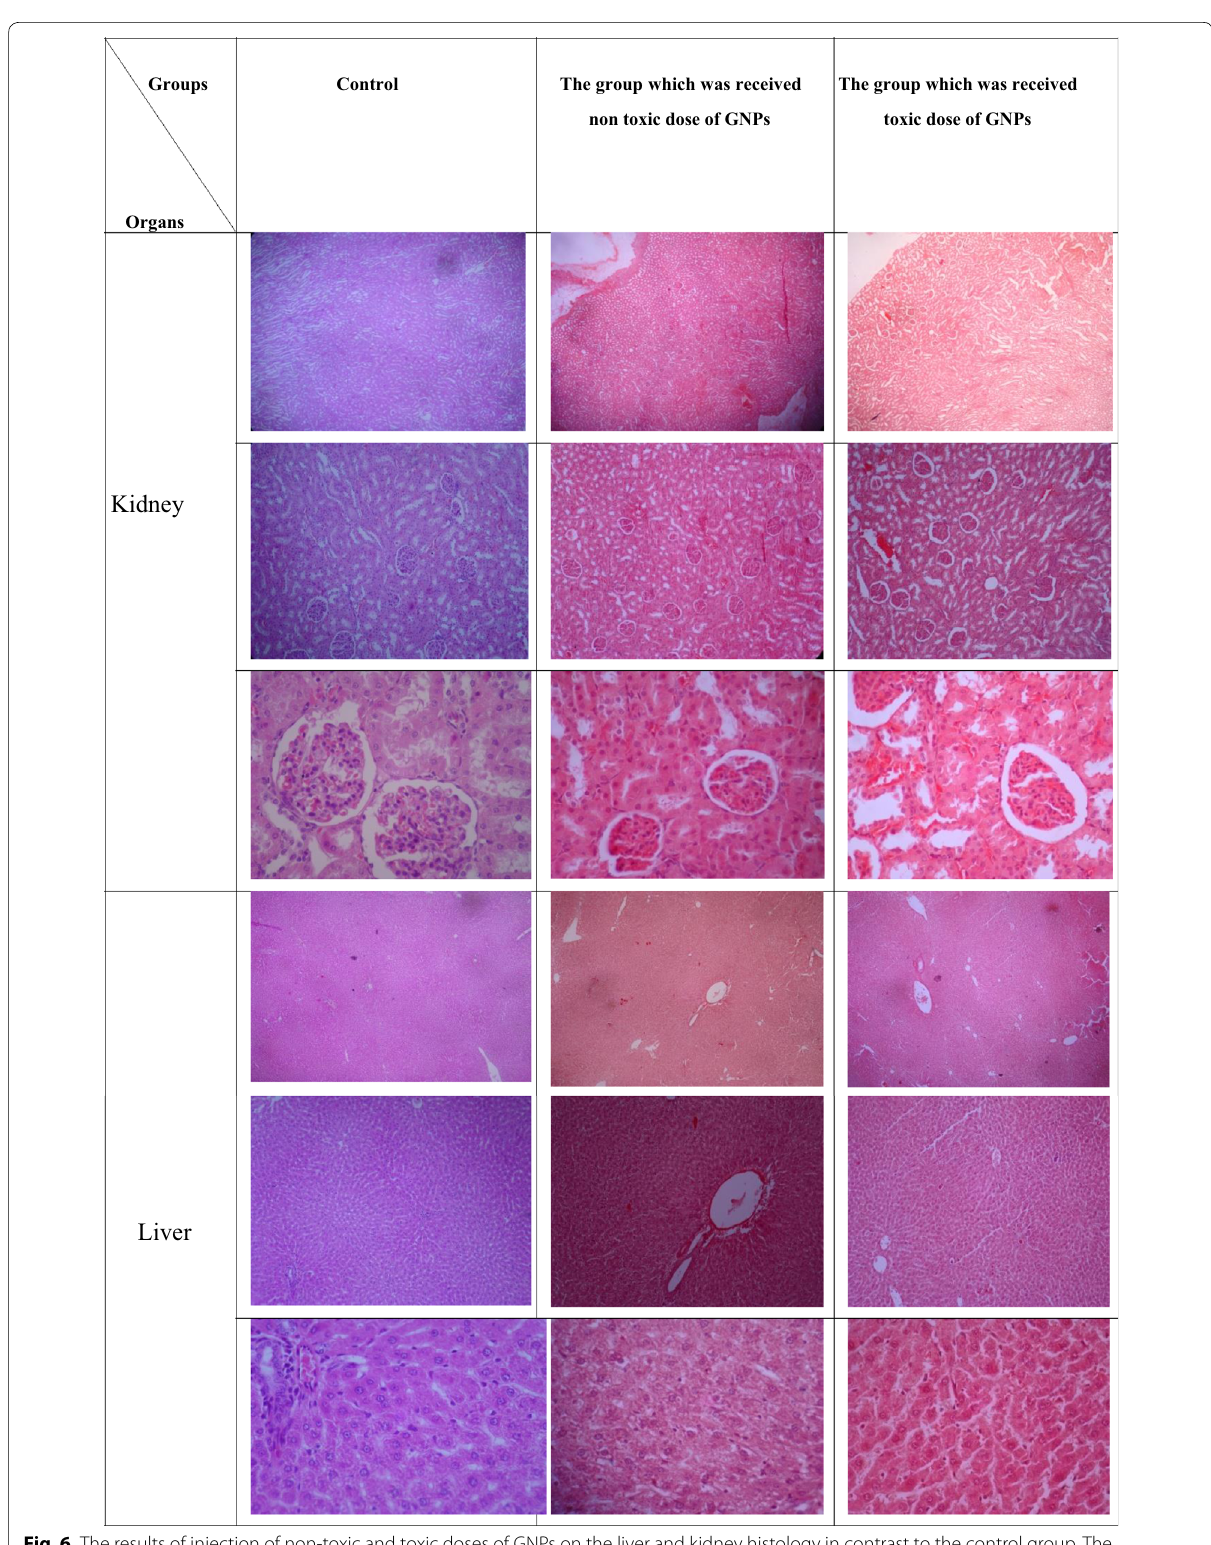
Fig. 6 The results of injection of non-toxic and toxic doses of GNPs on the liver and kidney histology in contrast to the control group. The magnification in the first row for each organ is